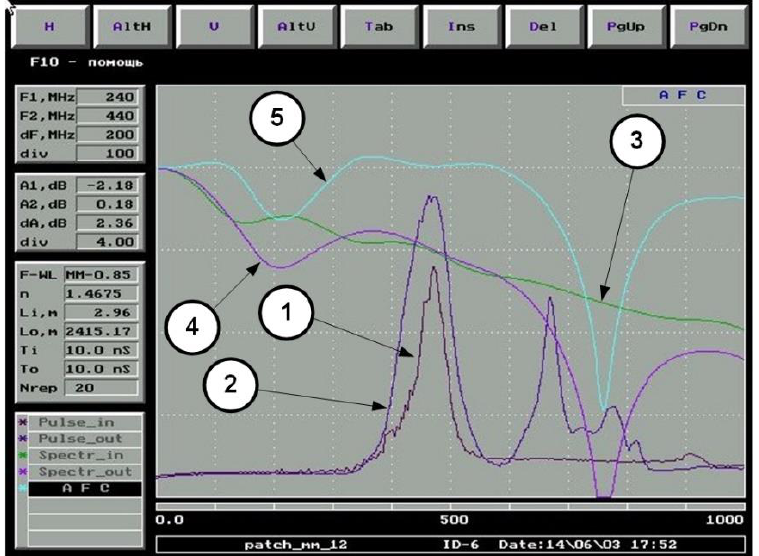
Figure 13. DMD analyzer workstation R2D2 software screenshot: “1” is the reference pulse; “2” is the pulse response at the output of tested optical fiber; “3” is the amplitude-frequency modulation response of the reference pulse; “4” is the amplitude-frequency modulation response of the distorted pulse; and “5” is the resulting sum amplitude-frequency modulation response.